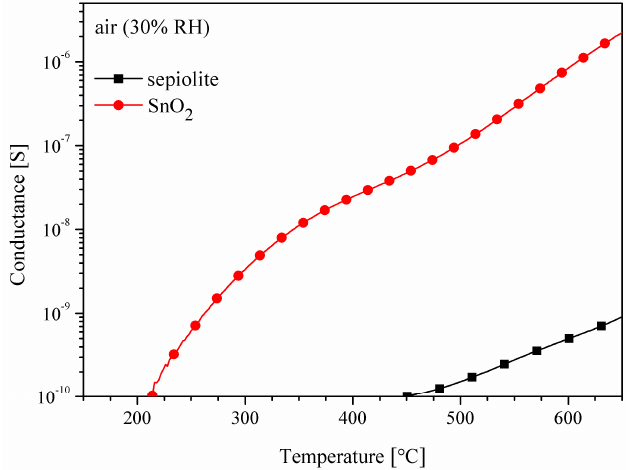
Figure 6. Thermal changes in the conductance of the sensors with the SnO 2 layer or only the sepiolite layer in synthetic air.